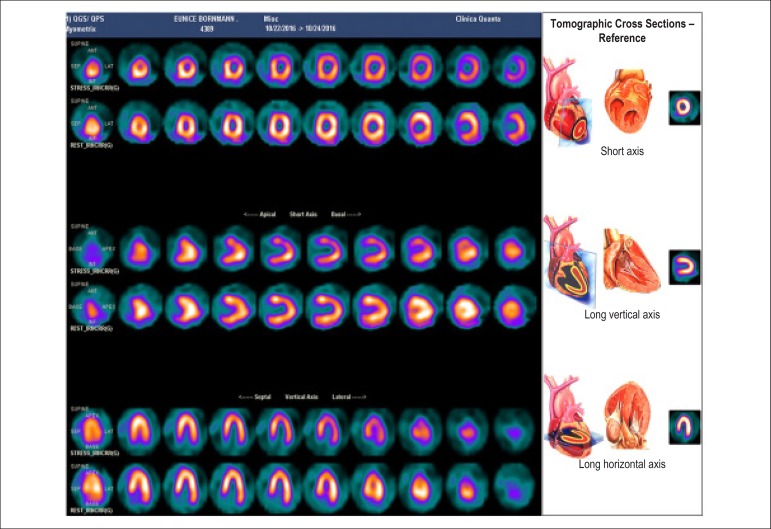
Case 11 - Myocardial perfusion scintigraphy (MPS) demonstrating moderate ischemic burden in the anterior wall, extending to the anterolateral wall of the left ventricle. Images acquired with dedicated cardiac equipment (gamma camera), equipped with conventional sodium iodide crystals.